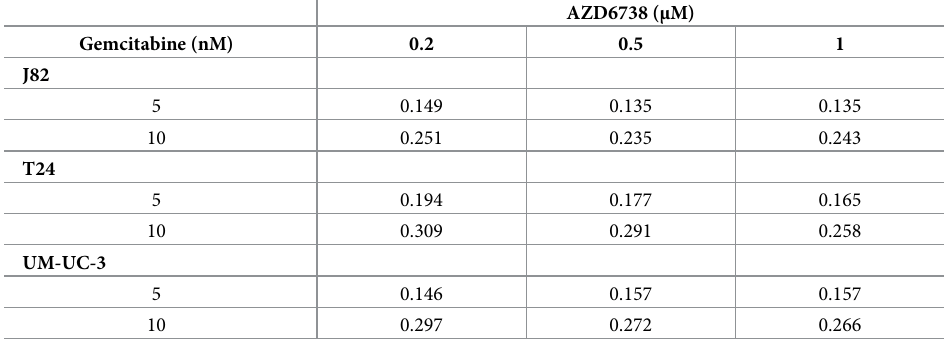
Table 1. Combination indices. Combination indices (CIs) calculated for the combination of gemcitabine and AZD6738 in bladder cancer cells (CI < 1 indicates synergy).